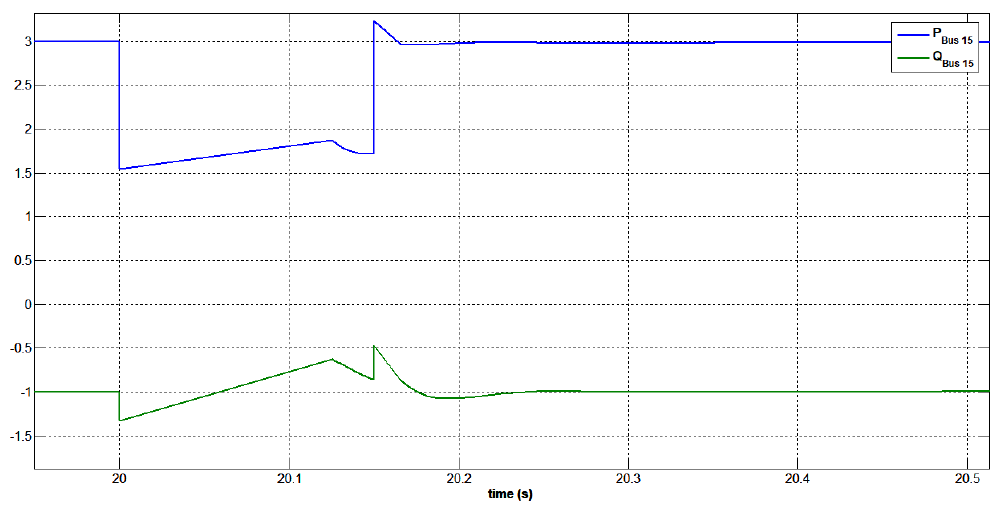
Figure 47. Generated active and reactive power at bus 15 under a three-phase short circuit at bus 15 with STATCOM.